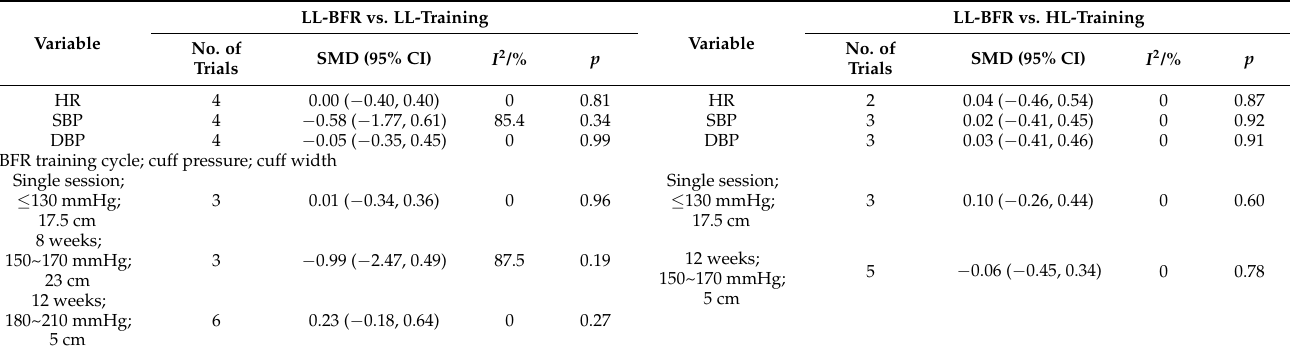
Table 5. Results of subgroup analysis on resting hemodynamic outcomes.